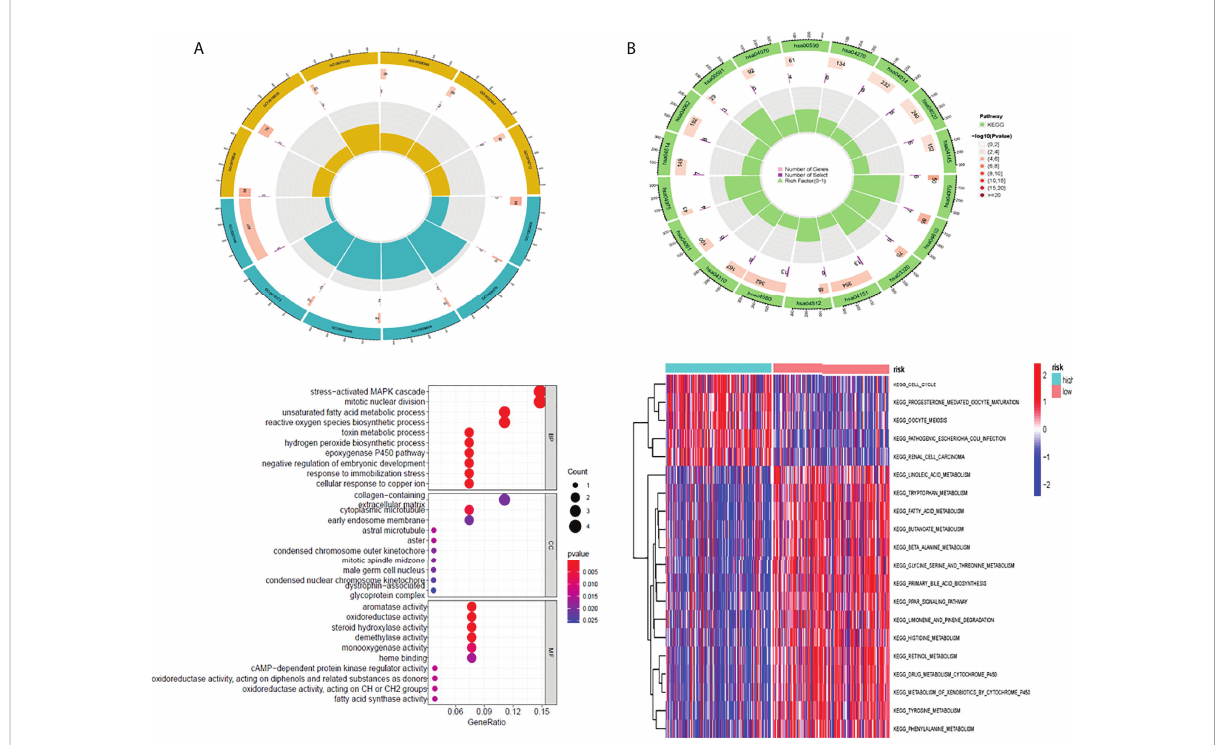
FIGURE 5 The result of GO and GSVA pathway enrichment analyses. The result of GO and GSVA pathway enrichment analyses (A) Biological process, cellular component, molecular function GO terms for risk DEGs (B) GSVA pathways for DEGs The top 10 sorted by the GeneRatio of GO terms and the top 20 sorted by GSVA pathways are shown. GO, Gene Ontology; GSVA, gene set variation analysis; DEGs, differentially expressed